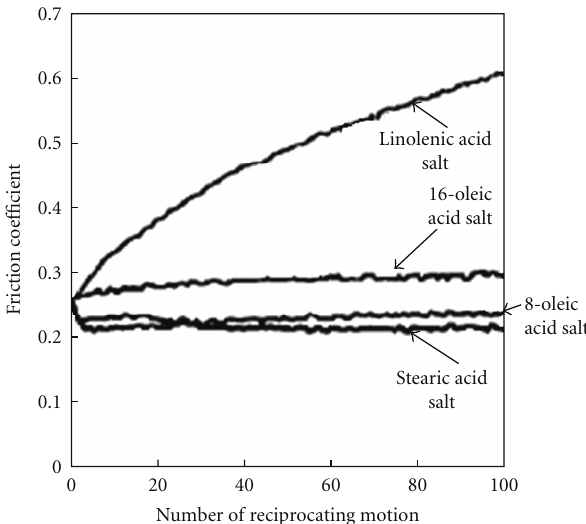
Figure 14: E ff ect of the number and position of the double bonds on the friction coe ffi cient at a concentration of 0.27 mmolL − 1 .